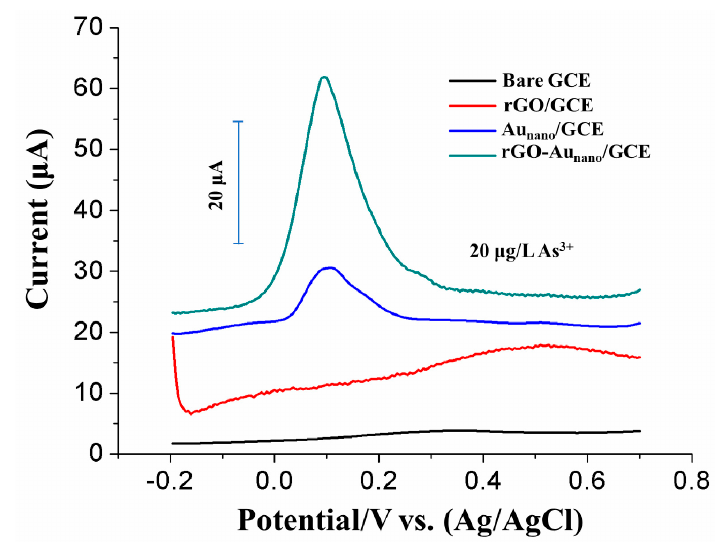
Figure 6. Comparison of SWASV curves for different modified electrodes used for the detection of 20 µ g/L As(III) at a deposition potential of − 0.3 V with a deposition time of 250 s in a 0.1 M nitric acid solution.